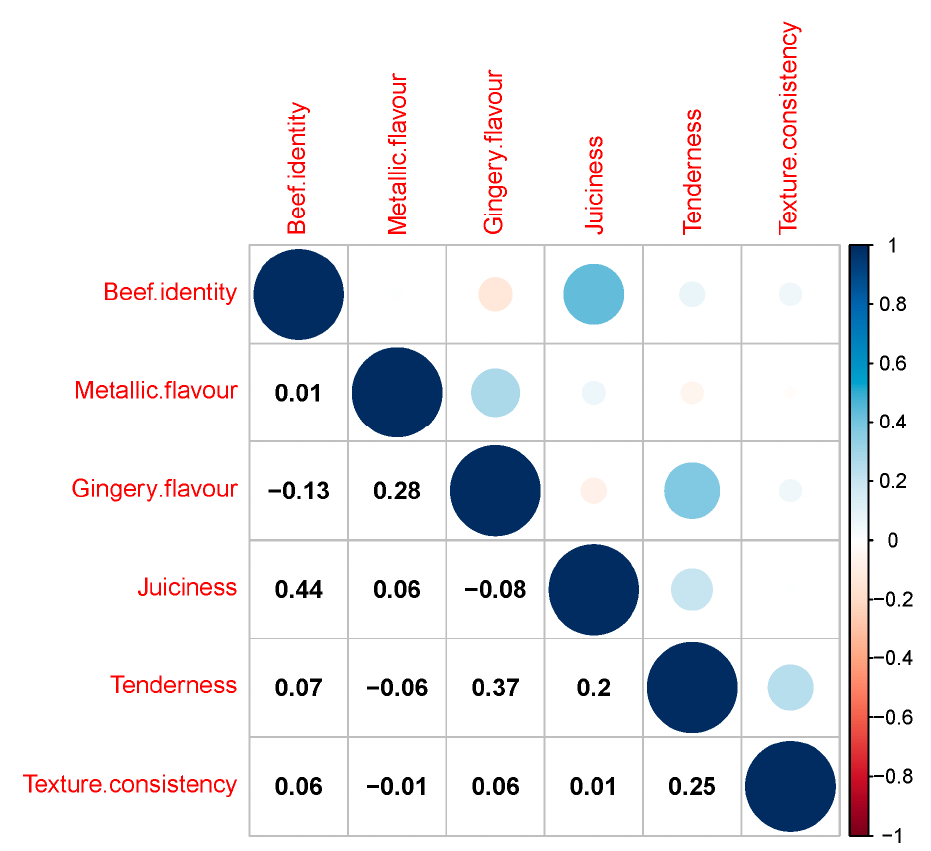
Figure 2. Plot of Pearson correlation coefficients of sensory attributes evaluated through trained panelists. Correlation values are shown below the diagonal and colour coding for size, and sign of correlations are shown above the diagonal. Correlations were calculated from sensory attributes of M. biceps femoris in control and ginger powder injection treated samples cooked for 8 h and 12 h. Blue dots indicate positive correlations and red dots represent negative correlations between the traits.